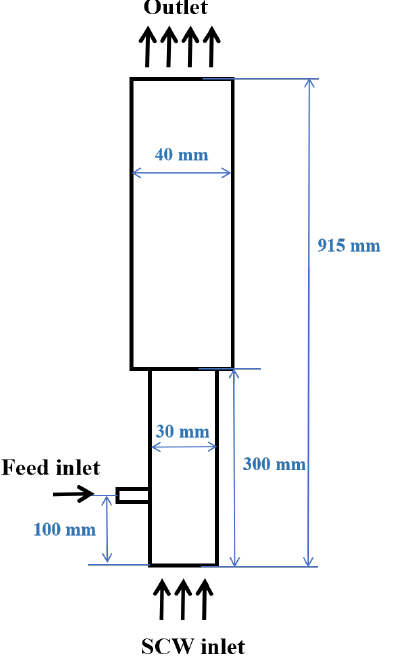
Figure 1. Sketch of the fluidized bed. Table 2. Computational conditions and model